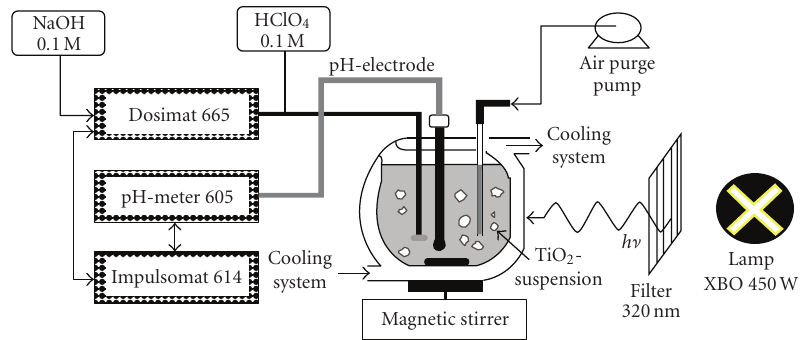
Figure 1: Schematic presentation of the photocatalytic reactor